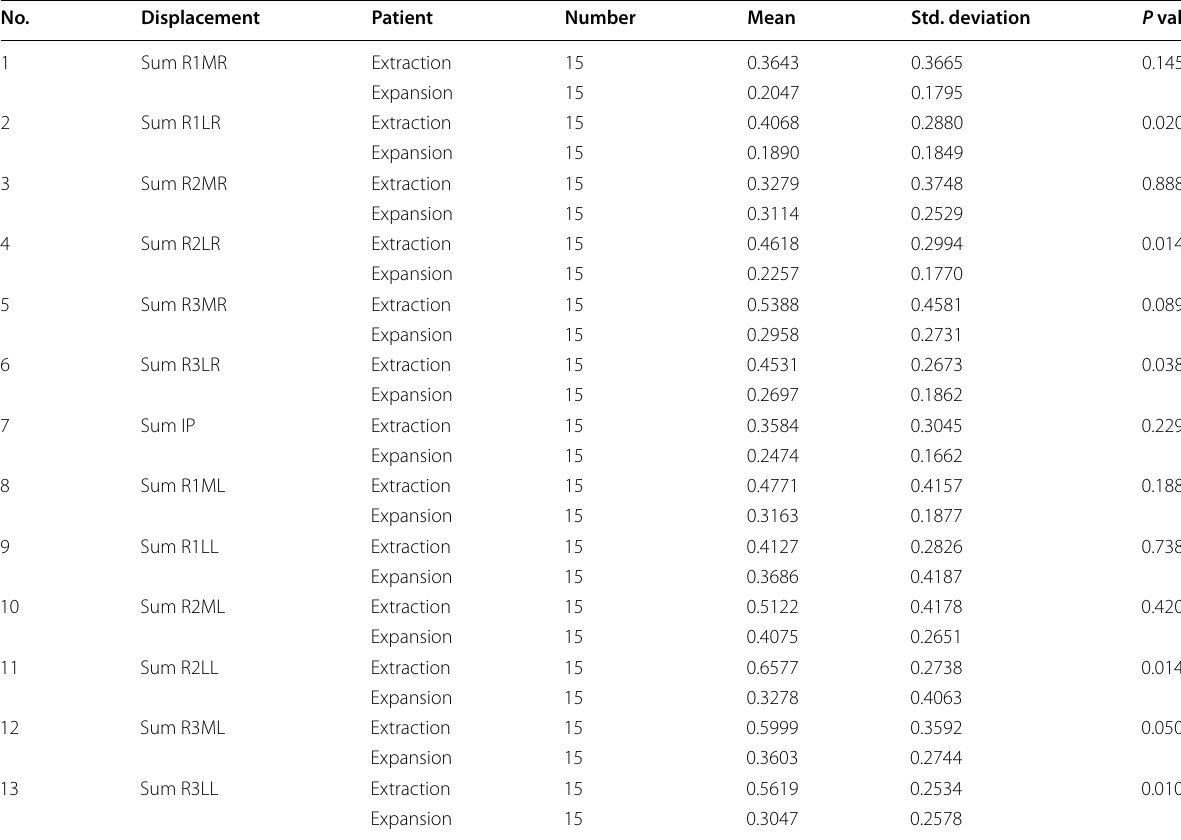
Table 4 Comparison in coordination changes of reference points after orthodontic treatment between extraction and expansion groups–right rugae (1–6); and left rugae and incisive papilla (7–13)